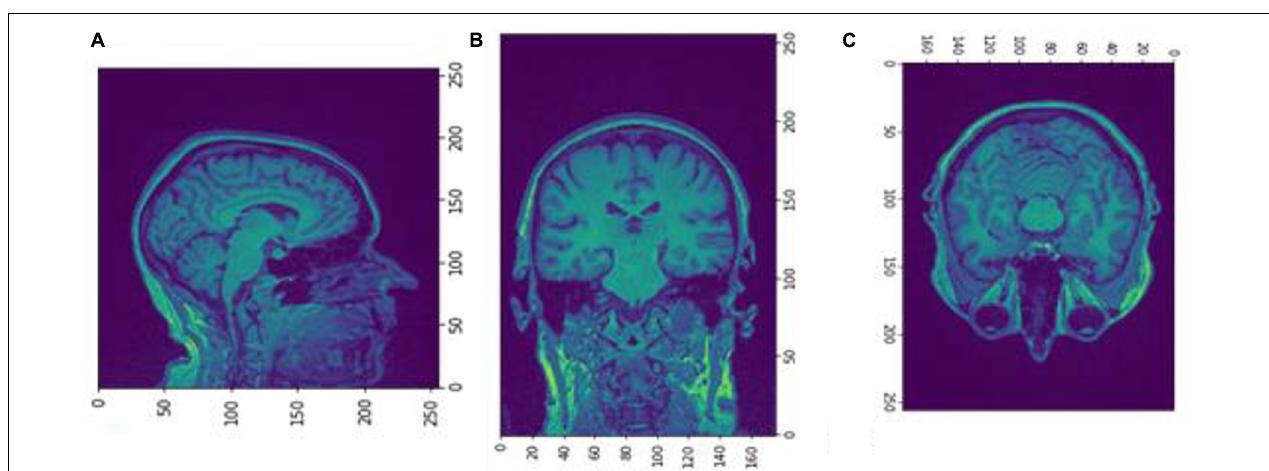
FIGURE 4 | Slices (A) Sagittal, (B) coronal, and (C) axial planes. The output of FreeSurfer of session OAS30001_MR_d0129. This volume is imported in FreeSurfer and later exported as a.mgz file. The images are shown using NiBabel library version 3.2.1 (https://zenodo.org/record/4295521#.YCpJqeqxWMI).